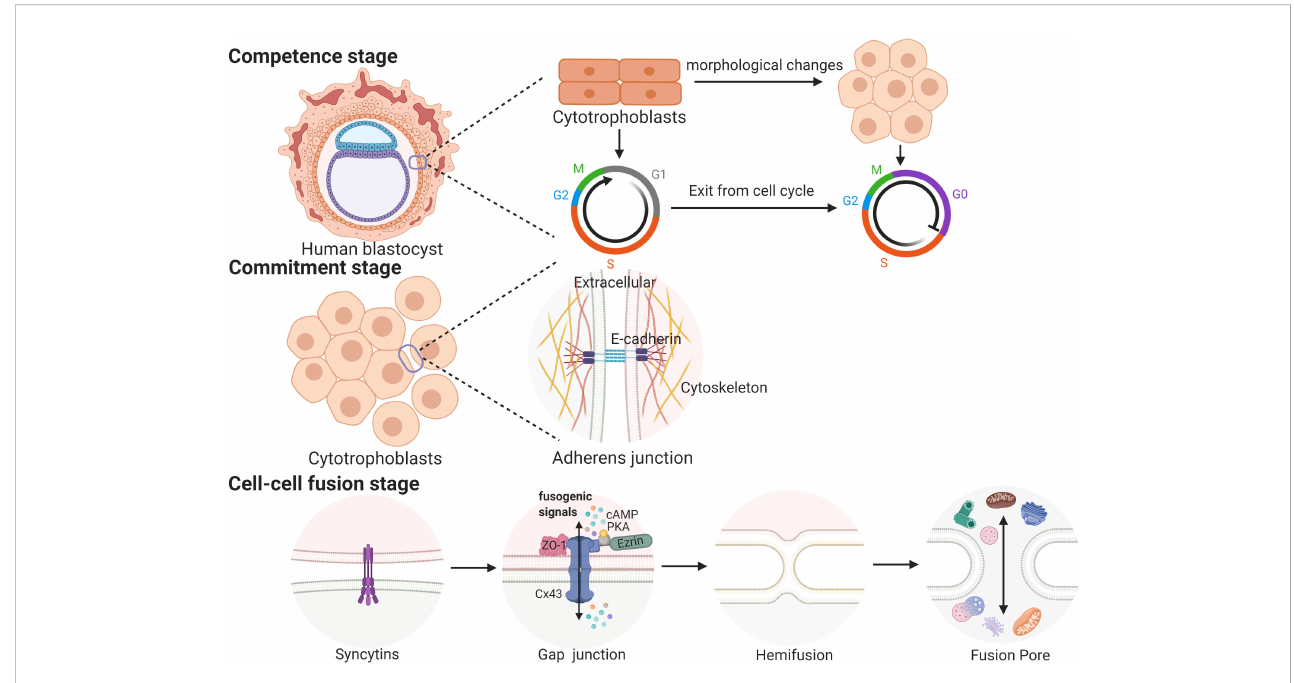
FIGURE 1 The three stages of trophoblast